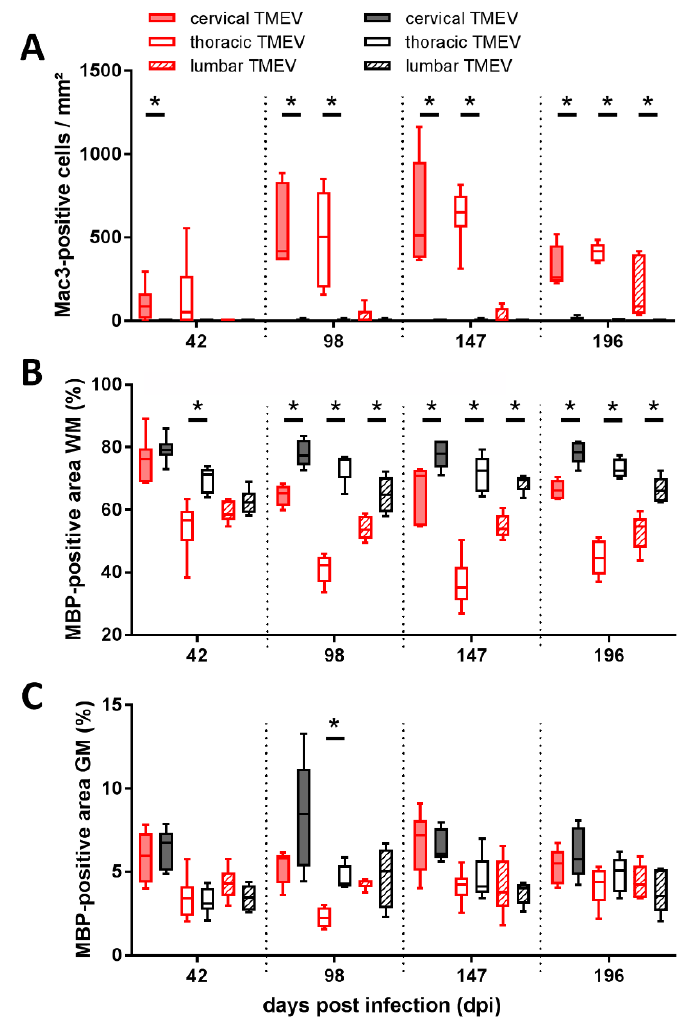
Figure 3. Evaluation of infiltrating macrophages within the area of the rostral reticulospinal tract revealed a significant increase in Mac3 + cells within the cervical segment at 42 dpi, within the cervical and thoracic segment at 98 and 147 dpi as well as within all investigated segments at 196 dpi ( A ). Assessment of myelin basic protein (MBP) stained slices revealed a significantly reduced MBP positive white matter (WM) area in the thoracic segment at 42 dpi and in all investigated segments at 98, 147, and 196 dpi ( B ). Moreover, the thoracic segment showed a significant reduction of MBP positive area in the gray matter (GM) at 98 dpi ( C ). No significant differences between TMEV-infected groups comparing 147 and 196 dpi were detected. Graphs display box and whisker plots. Significant differences between groups detected by Mann–Whitney U -test were indicated by asterisks (* p ≤ 0.05).